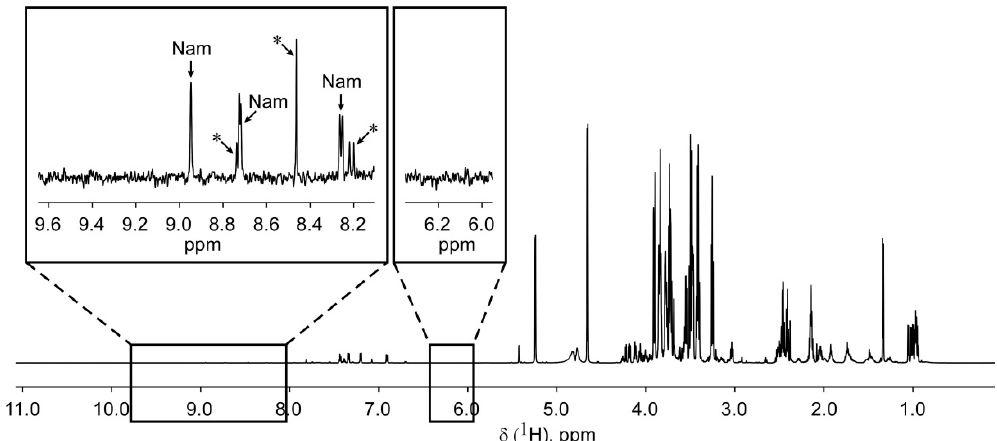
Figure 5. Detection of NAD + intermediates in cell culture medium. Proton nuclear magnetic resonance spectrum of Dulbecco’s Modified Eagle’s Medium (DMEM) supplemented with 10% fetal bovine serum contains Nam as the only NAD + precursor. Two spectral regions containing peaks corresponding to NAD + intermediates are expanded. Asterisks designate unidentified peaks. nt =